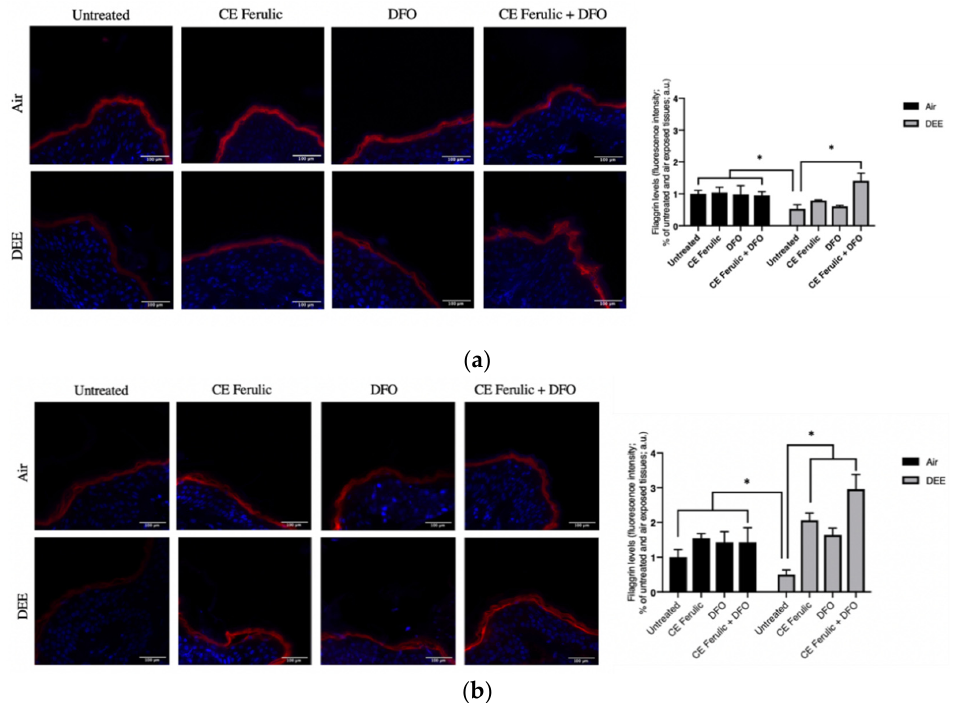
Figure 5. Skin exposure to DEE induces a decrease in filaggrin levels, while topical application of CE Ferulic and DFO prevents this effect. Levels of filaggrin in ex vivo human-skin explants untreated or pretreated with the cosmeceutical formulation mixture and DFO, alone or in combination, and exposed to air or DEE at Day 1 ( a ) and Day 4 ( b ). Red fluorescence staining represents filaggrin immunoreactivity, while cell nuclei are stained in blue with DAPI. Original magnification 40x. On the right, semi-quantification of the immunofluorescence intensities performed by ImageJ are shown in the histograms. Data are expressed as arbitrary units (averages of three independent experiments), * p < 0.05, by ANOVA. Scale bar = 100 μ m.